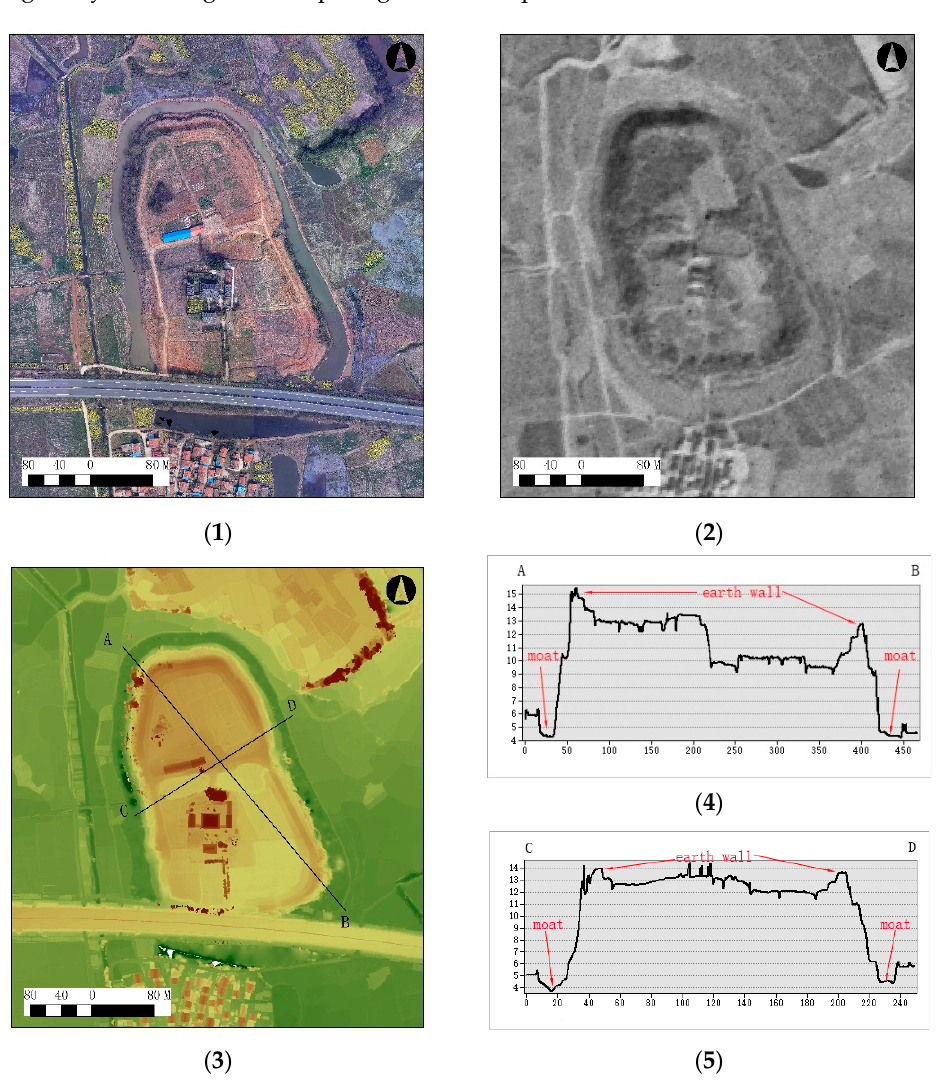
Figure 3. Remote sensing images of the Yishengsi site (( 1 ) is the DOM of Yishengsi, ( 2 ) is the CORONA satellite image taken in 1970, ( 3 ) is the DSM of Yishengsi, ( 4 , 5 ) is the profile of Yishengsi). Table 1. Sites coordinates and layout